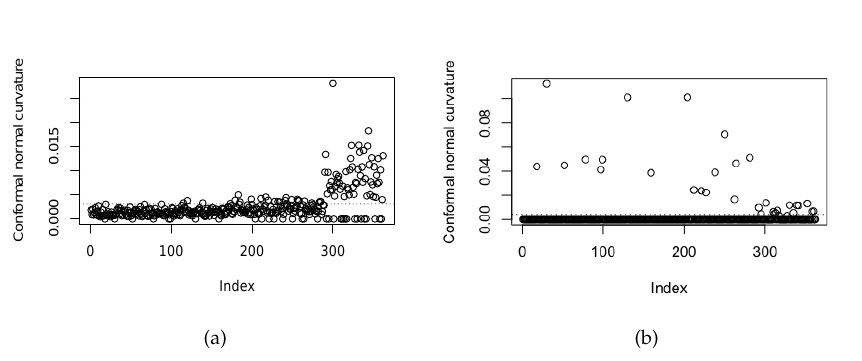
Figure 2. Index plots of local influence for asthma data: ( a ) y ij = 0 and ( b ) y ij =